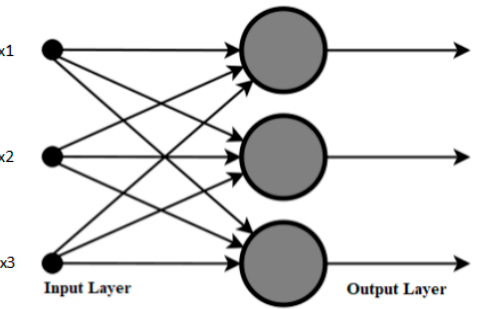
Figure 3. General structure of a feed ‐ forward neural network (FFNN). Figure 4. General structure of a feed-forward neural network